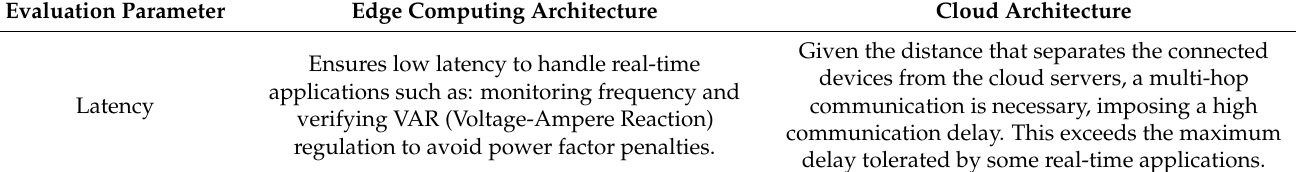
Table 2. Comparison between edge and cloud architectures based on